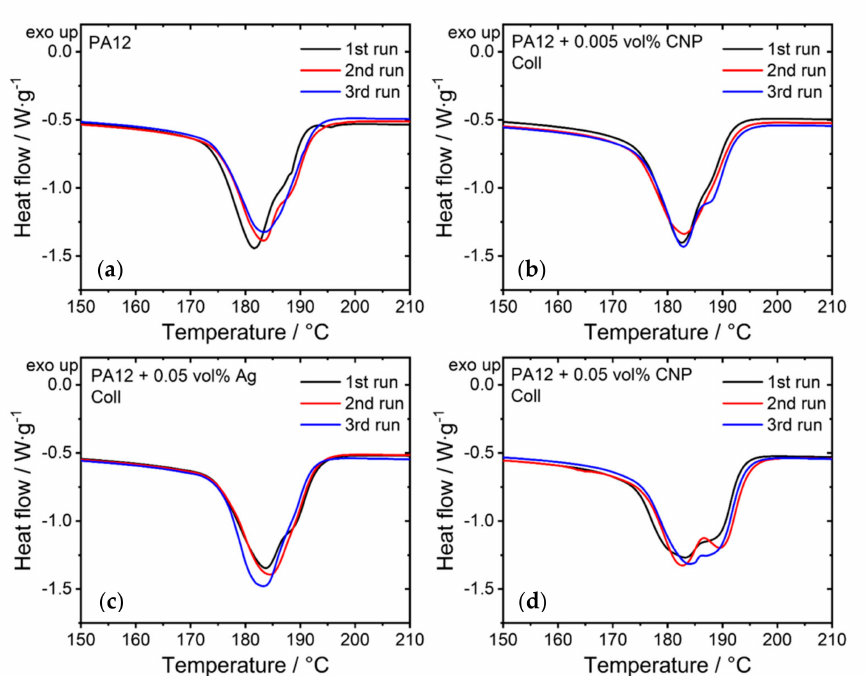
Figure 2. Three heating curves of the LB-PBF-P specimens made of ( a ) pure PA12, ( b ) PA12 and 0.005 vol% carbon nanoparticles, ( c ) PA12 and 0.05 vol% silver nanoparticles, and ( d ) PA12 and 0.05 vol% carbon nanoparticles. The addition of the nanoparticles was performed via colloidal additivation. The heating rate was 10 K/min.